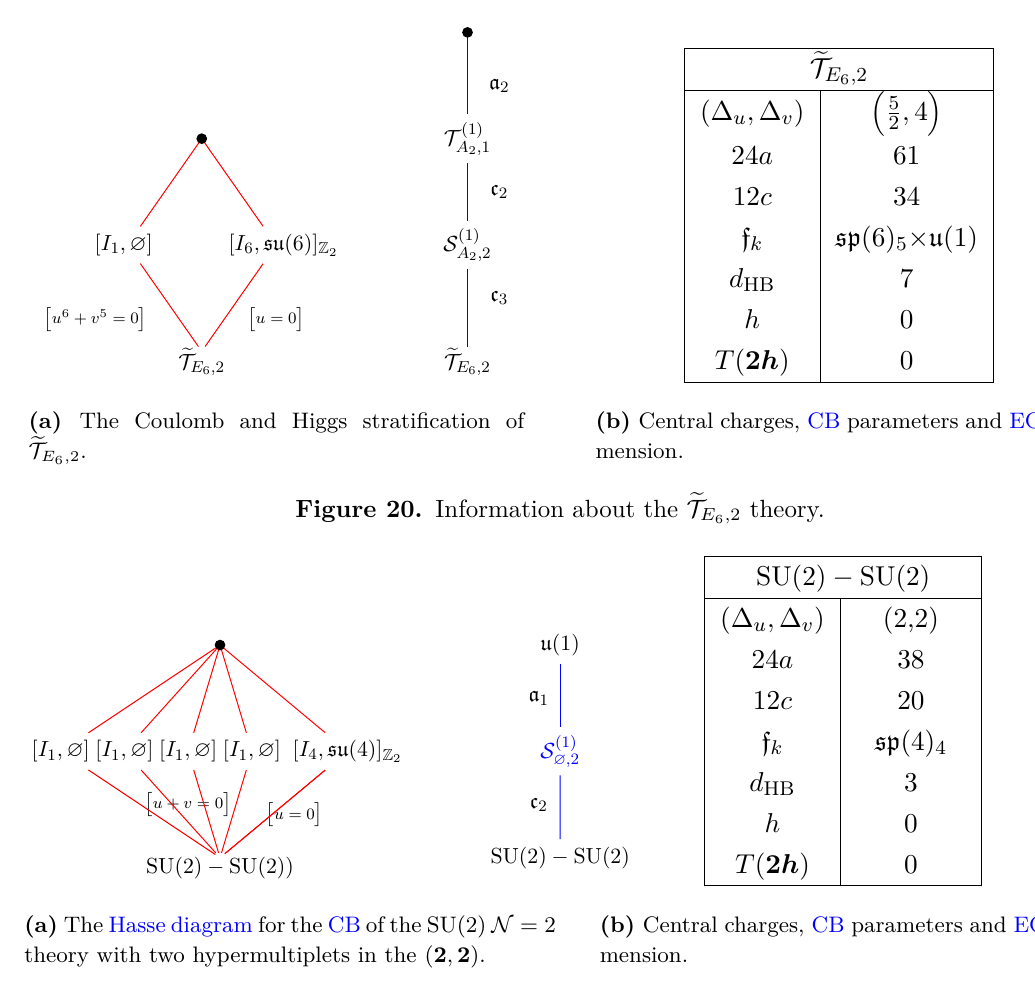
Figure 21. Information about the SU(2) N = 2 theory with two hypermultiplets in the ( 2 , 2 )